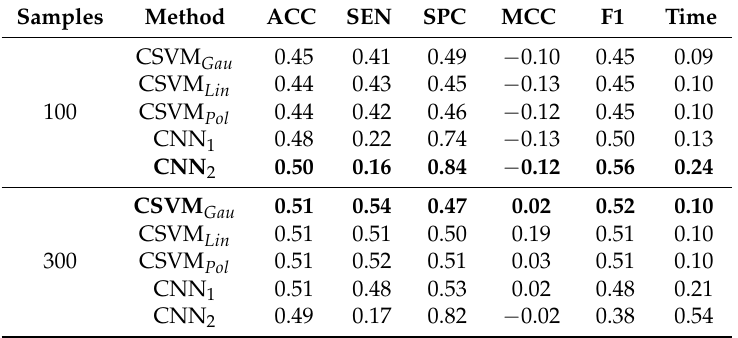
Table 4. Simulation results for convolutional methods with µ difference equals to 3SD. The time column refers to the model’s training time. The suitable model performance is highlighted in bold for each